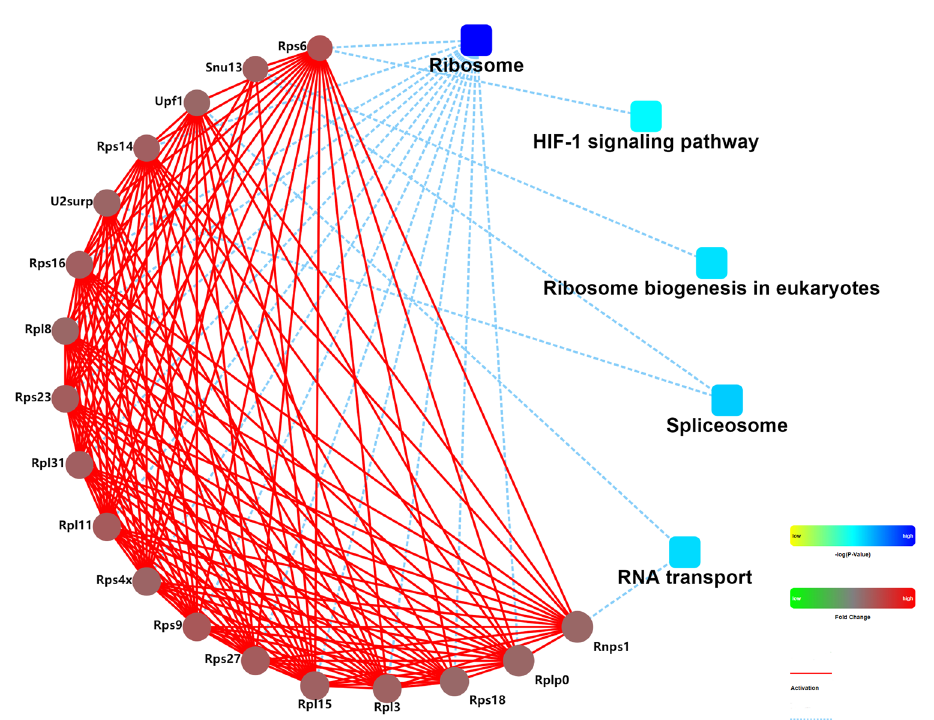
Figure 7. Protein–protein interaction(PPI) network of differentially abundant proteins in V79 cells. The analysis was based on the fold changes of differentially abundant proteins, PPIs and KEGG pathway. Circle nodes represent proteins. The rectangles represent KEGG pathways, colored with gradient colors from yellow (lower P-value) to blue (higher P-value). Proteins abundant changed are colored with red (up-regulation) and green (down-regulation). 400 was used as a default confidence cutoff. The red solid lines represent activation. The blue dashed lines indicate KEGG